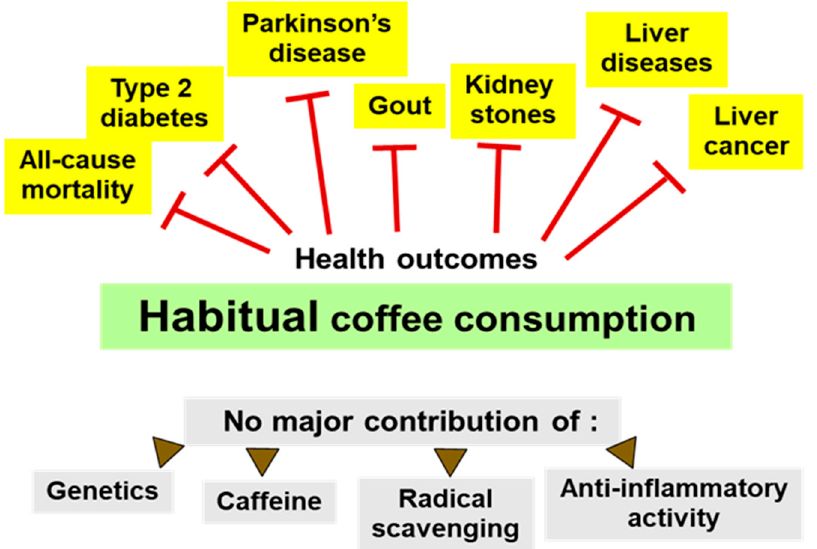
Figure 1. Health outcomes of coffee consumption. Prospective epidemiological studies consistently found a lower risk of several clinical outcomes and of all-cause mortality for habitual coffee consumption [1,2]. Most of these associations cannot be accounted for by genetic polymorphisms promoting coffee/caffeine consumption, by the caffeine content of coffee, or by its content of radical scavenging or anti-inflammatory constituents. Health effects of decaffeinated coffee could only be determined if sufficiently large cohorts were available for study. Otherwise, positive trends did not reach statistical significance, such as for Parkinson’s disease.